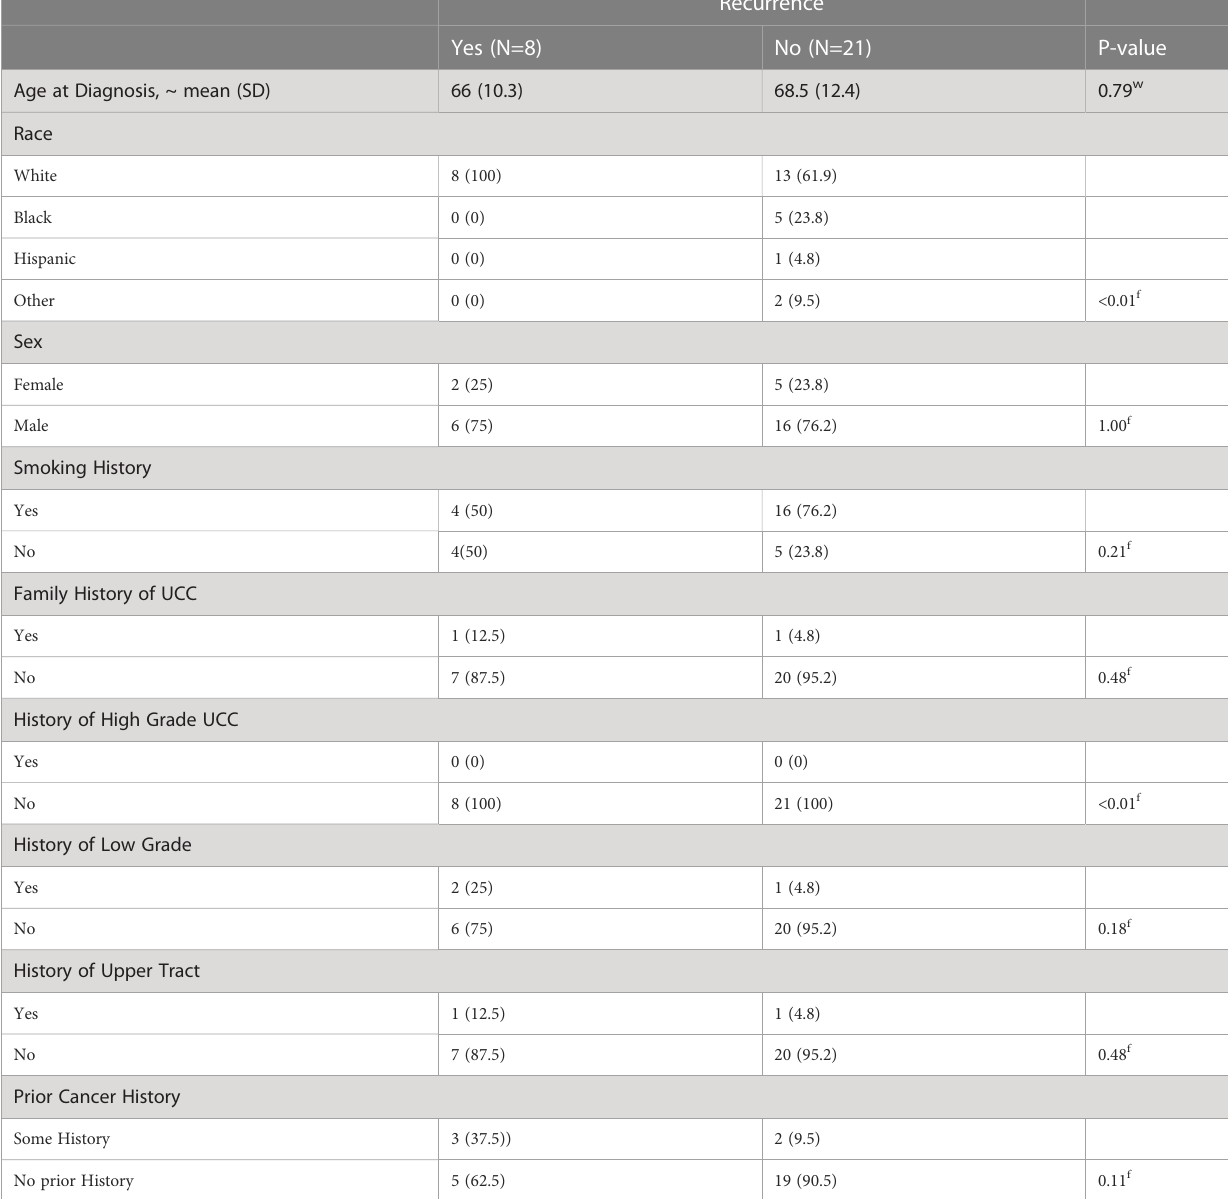
TABLE 2 Participants characteristics (with recurrence